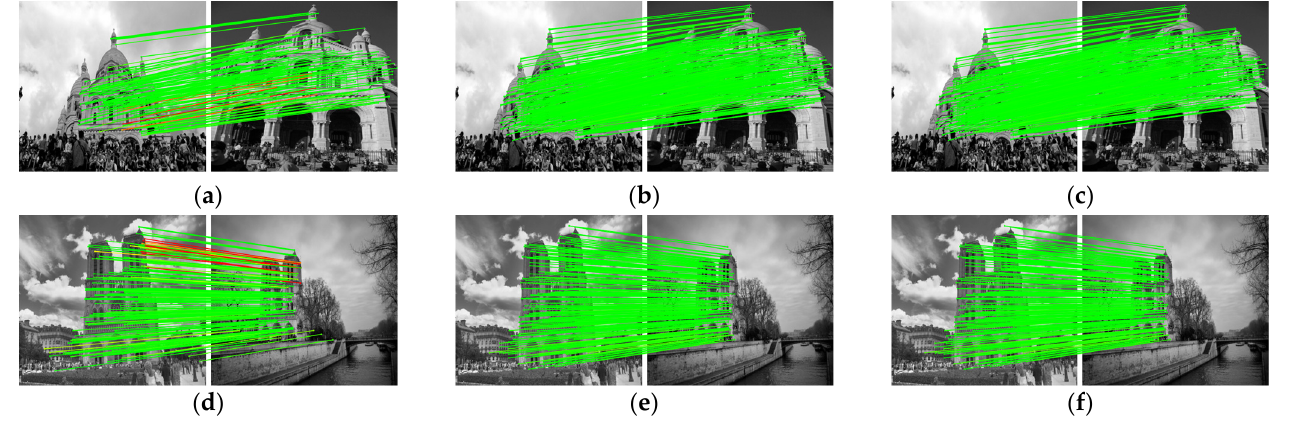
Figure 11. The visualized matching result on YFCC100M. The red lines represent mismatches, and the green lines represent correct matching. ( a ) The results of OANet. ( b ) The results of SuperGlue. ( c ) The results of AdaSG. ( d ) The other results of OANet. ( e ) The other results of SuperGlue. ( f ) The other results of AdaSG. Table 3. Outdoor experiment on the YFCC100M